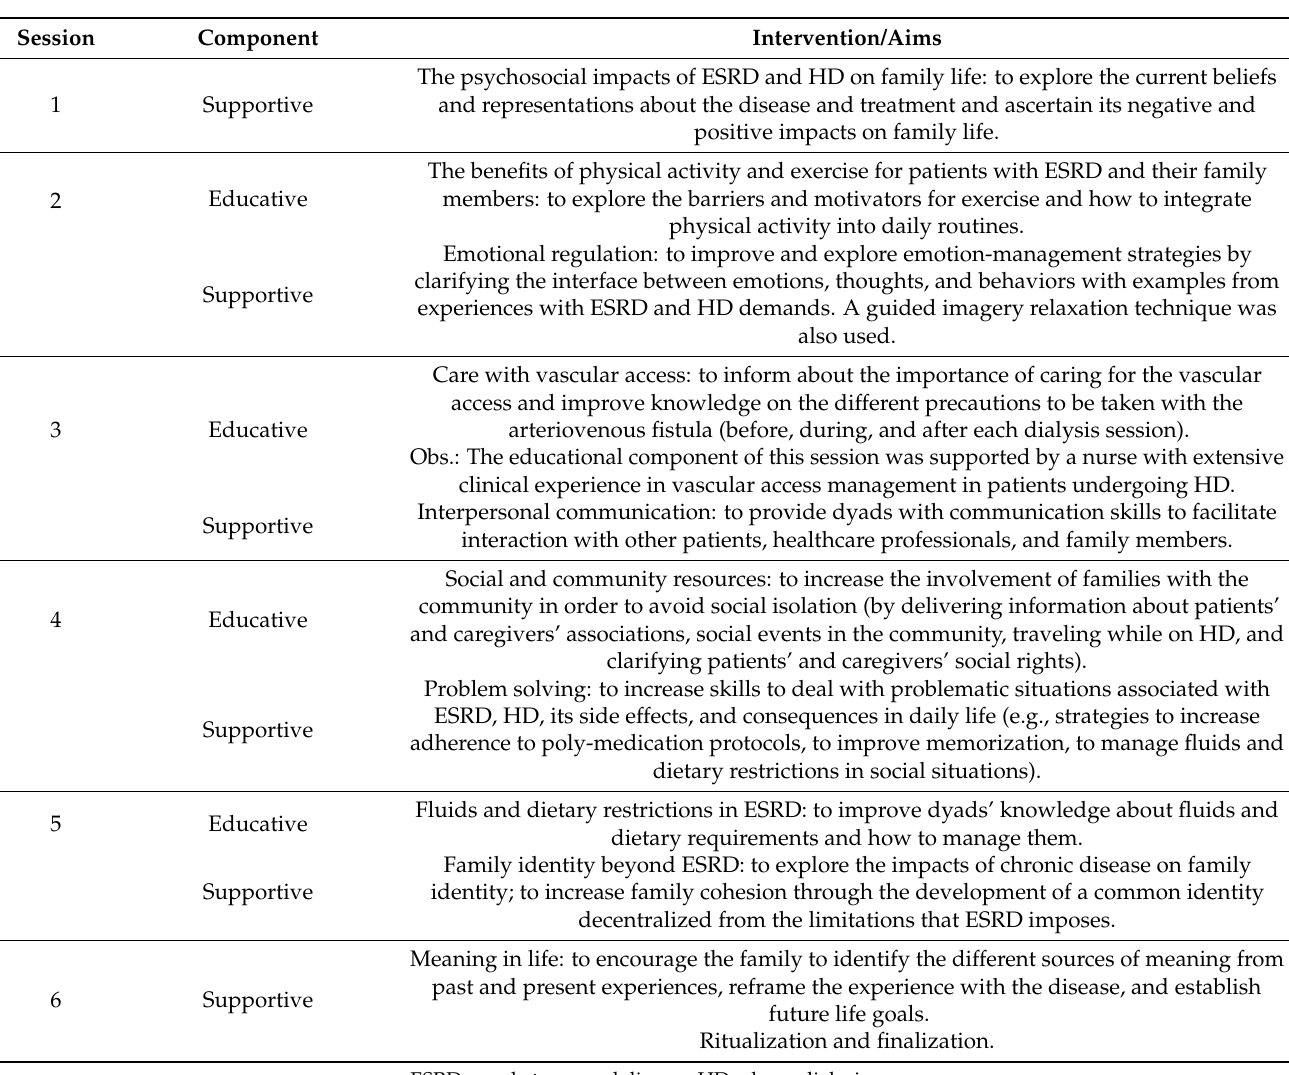
Table 1. Content of the intervention